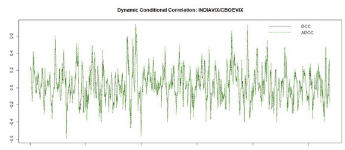
Fig. 4. Dynamic Conditional Correla- tion at D3 Scale